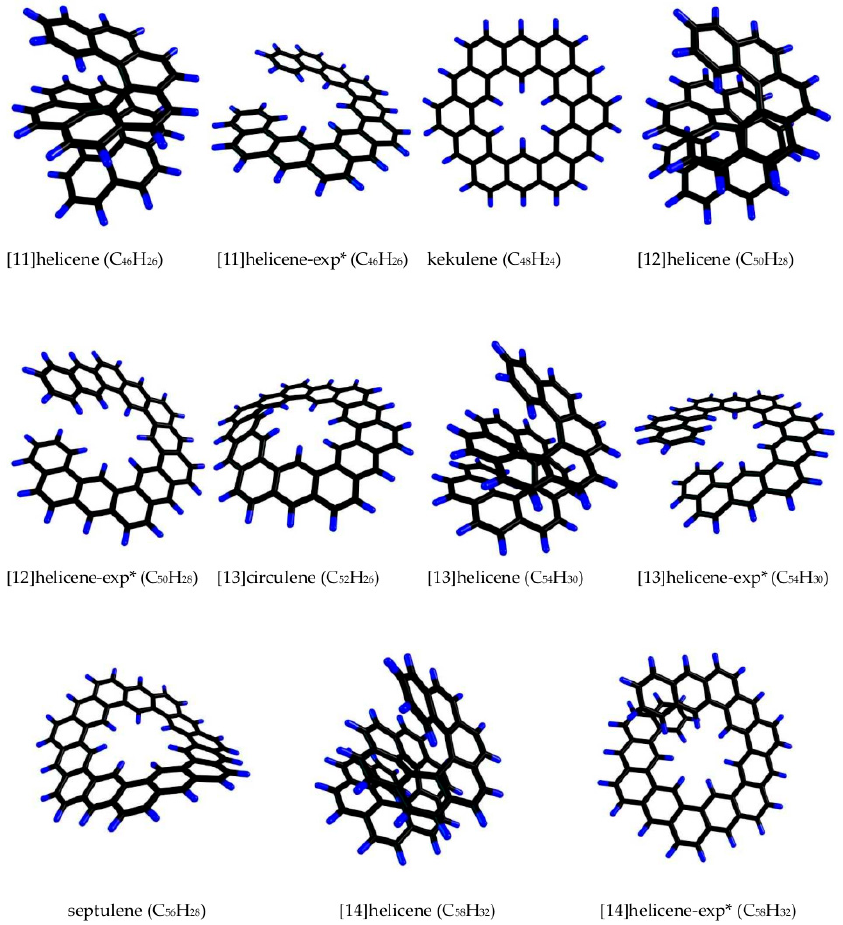
Figure 1. All polycyclic aromatic hydrocarbons under study. The energetically unfavorable confor- mations are not shown. Note: * Suffix “-exp” indicates expanded helicene structures. mations are not shown. Note: * Suffix “-exp” indicates expanded helicene